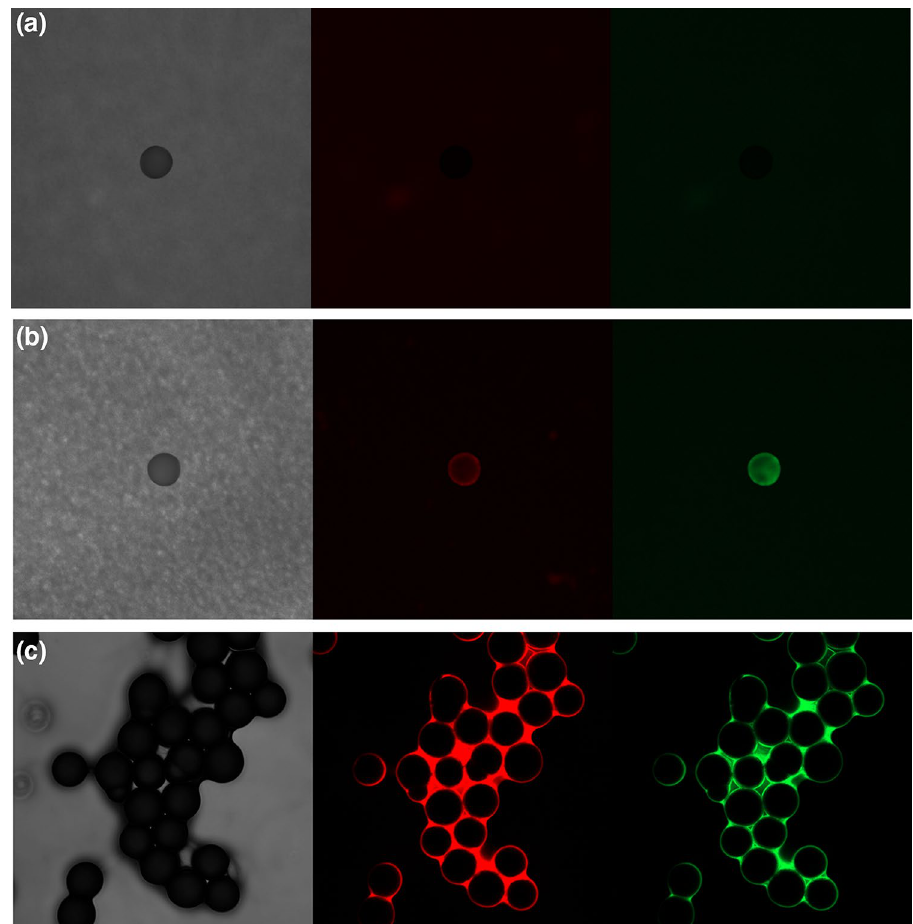
Figure 5. Fluorescent images with shadow (left) and at red wavelengths (middle) and green wavelengths (right). PE microspheres stained with a 5 μg/ml NR working solution in ( a ) methanol, ( b ) n -hexane and ( c )